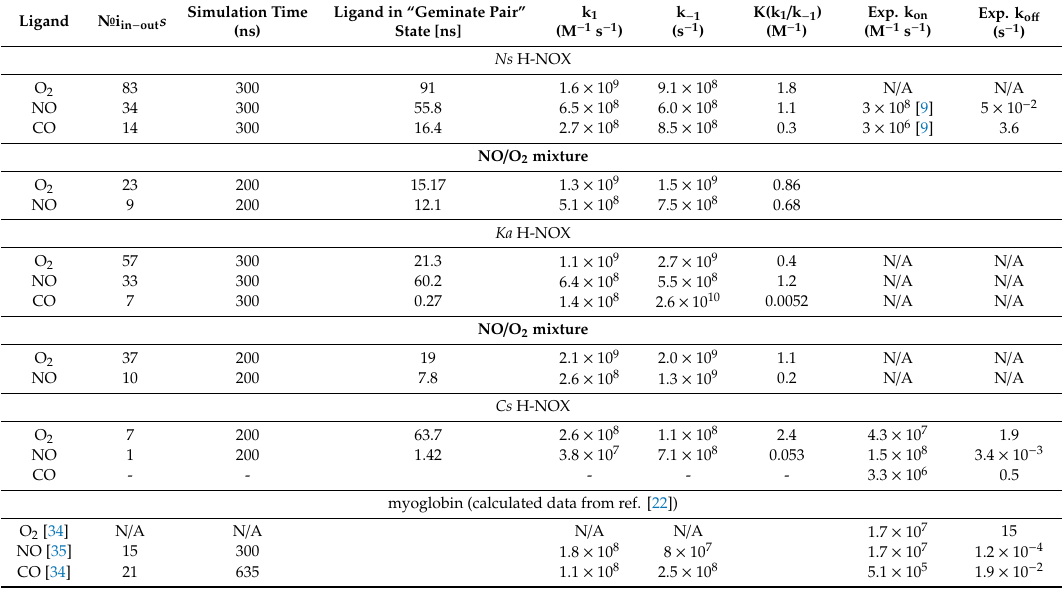
Table 1. Calculated and experimental rate constants and equilibrium constant for the di ff usion of diatomic gases into and from the active site of studied H-NOXs. Number of global in-and-out events (i in − out ) . The trajectory length used for the simulation and the time that the ligands spent in the distal pocket are given in ns. For comparison, previous results for myoglobin are also